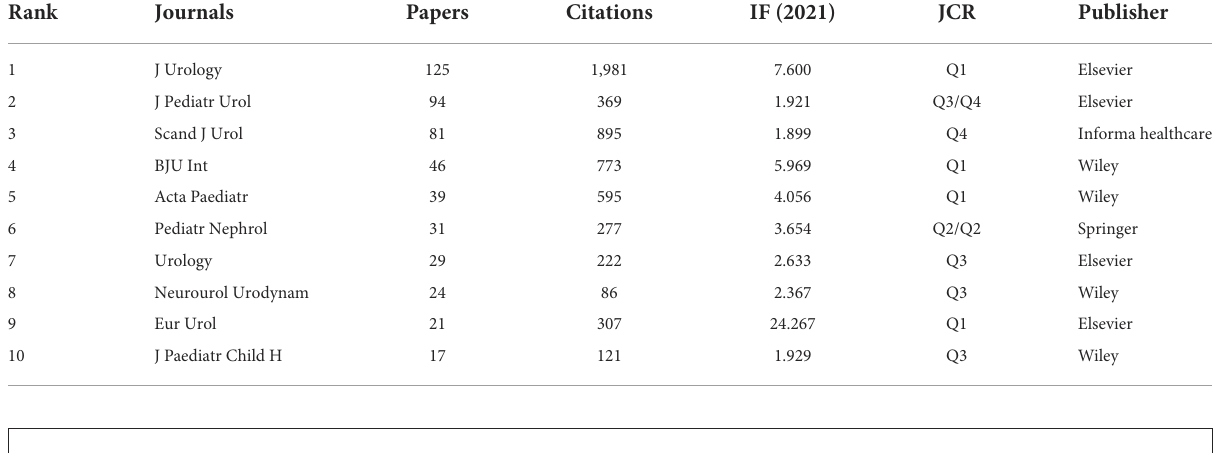
TABLE 2 The top 10 Journals of publications volume on NE From 1982 to 2022.